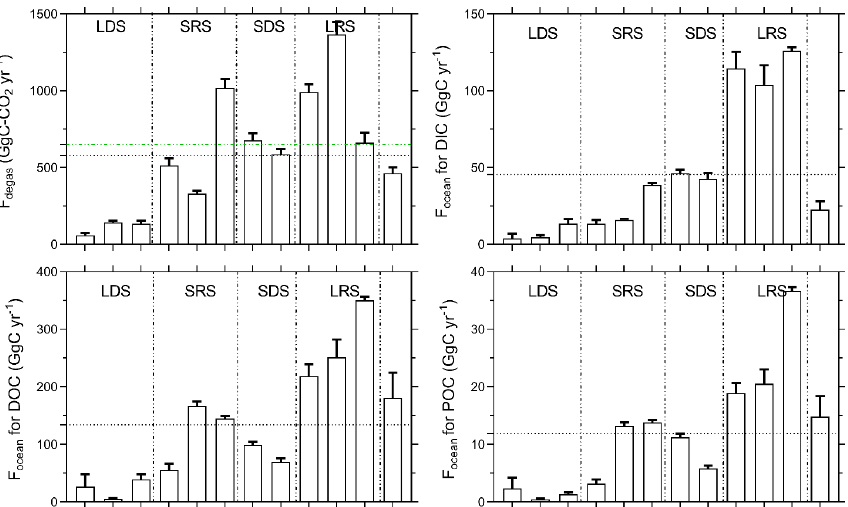
Figure 8. Monthly C fluxes at the Nyong watershed scale described in Sect. 2.4. For F ocean , the black dashed lines represent the yearly average of the different monthly C fluxes. For F degas , the green dashed line is obtained by summing yearly integrated CO 2 degassing in each stream order, as in Table 6, which represents 651.9 ± 160.6GgCyr − 1 . For F degas , the black dashed line represents the yearly average of the different monthly CO 2 degassing fluxes from the entire river network, as in Fig. 8, which represents 578.9 ± 157.9GgCyr − 1 . The figures are separated into the four seasons that occur in the Nyong watershed: LDS – long dry season, SRS – short rainy season, SDS – short dry season and LRS – long rainy